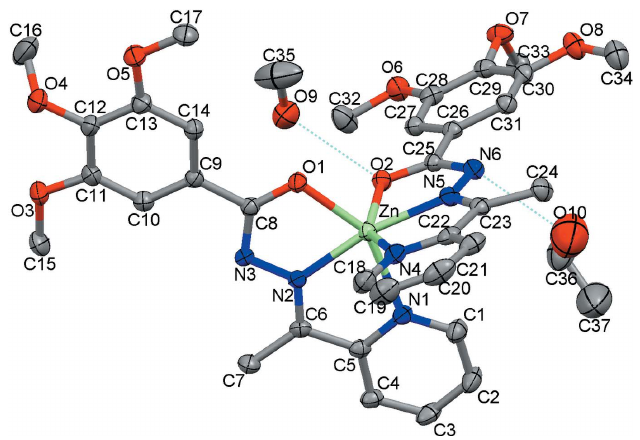
Figure 1 The title compound with the atom-numbering scheme. Displacement ellipsoids are drawn at the 50% probability level. H atoms have been omitted for